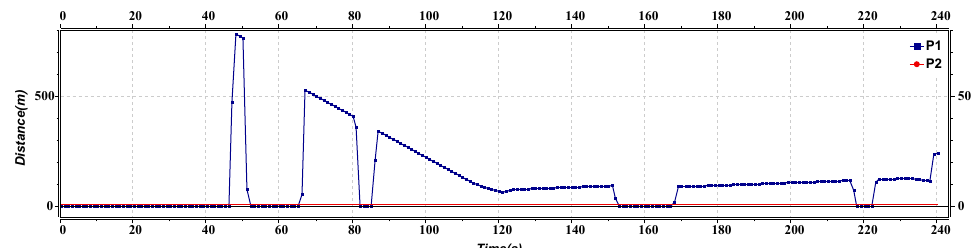
Figure 14. Distance versus time graph of lane